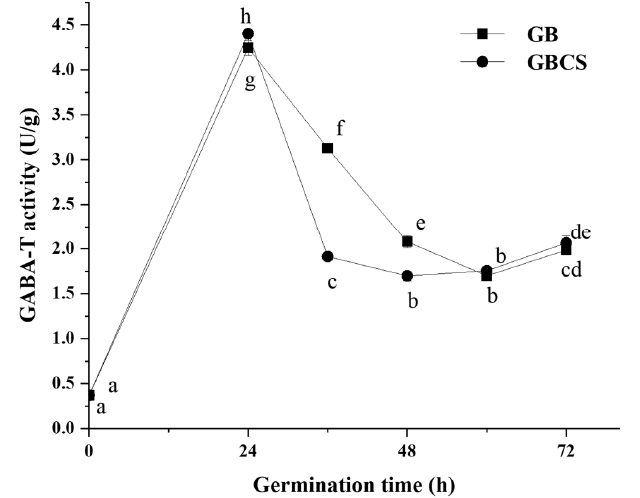
Figure 5. Change in GABA-T activity influenced by cold stress and germination. GB, germinated black rice grain without cold stress; GBCS, germinated black rice grain under cold stress at 0 °C for 1 h. Means with different small letter superscripts are significantly different at p < 0.05.